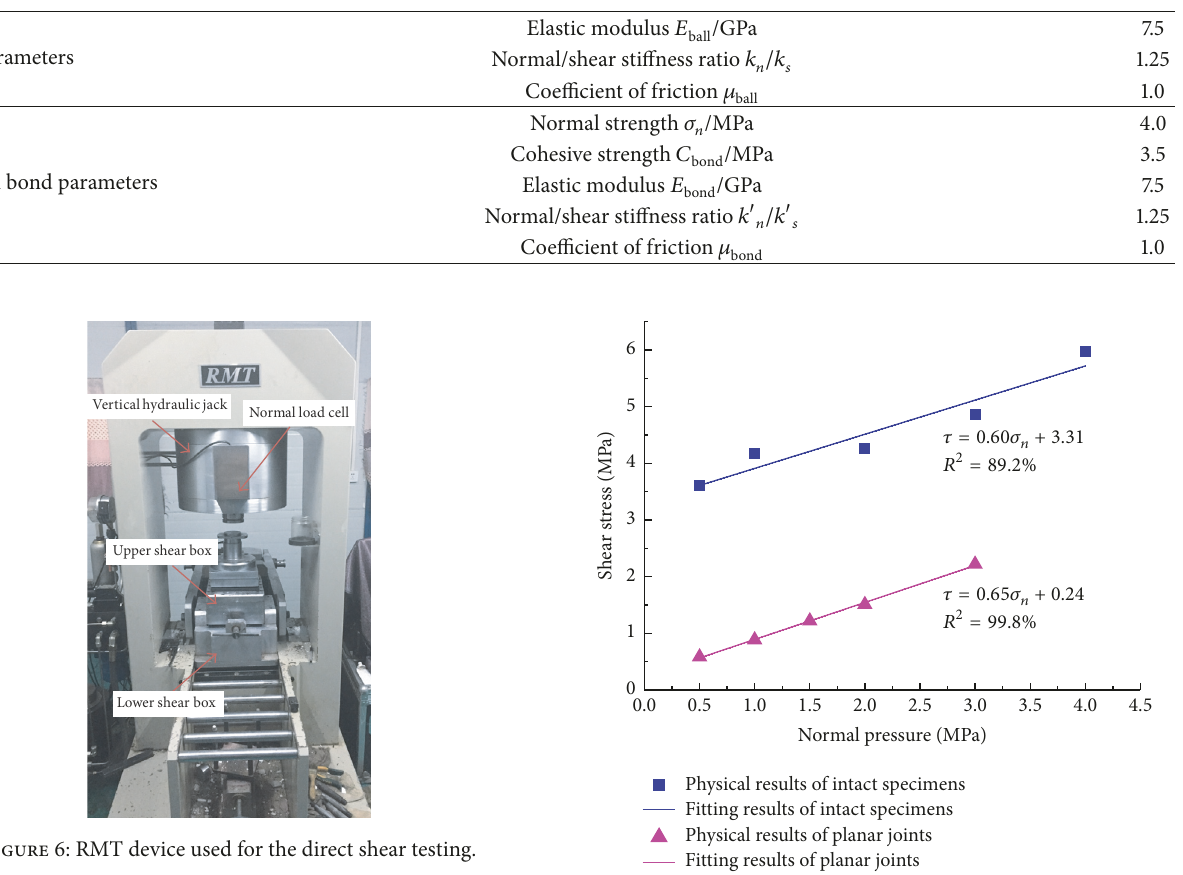
Figure 5: Laboratory test specimens with single bedding planes (the arrow indicates the shear direction). Table 1: Microscale parameters of the particles and parallel bonds.